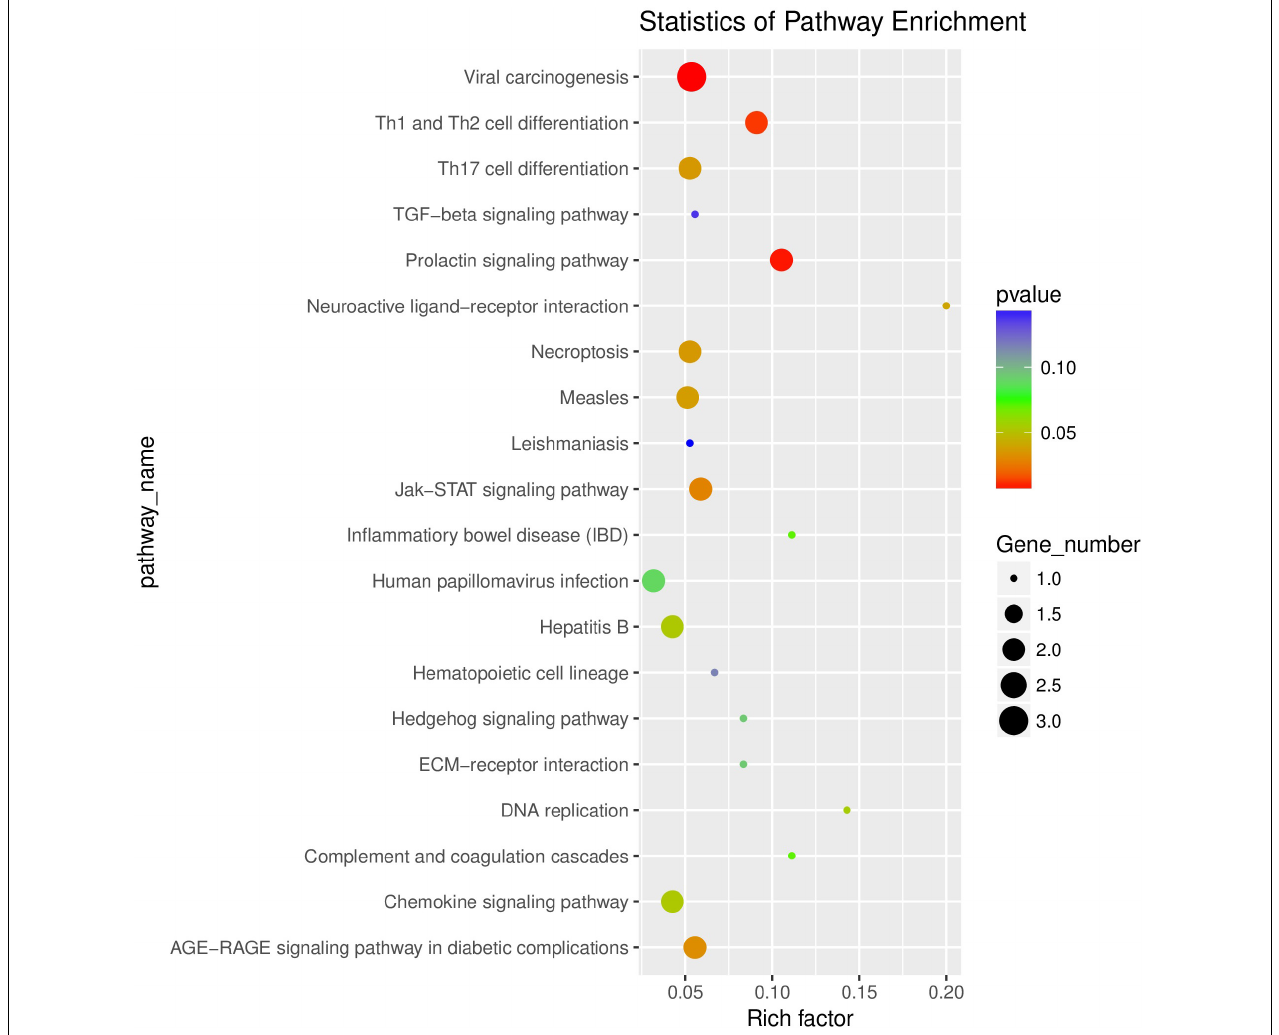
FIGURE 12 | Scatter plot of differential expression circRNA-hosting gene KEGG enrichment analysis. The abscissa is Rich factor (Rich factor = S gene number/B gene number). The ordinate is Pathway term, that is, KEGG metabolic